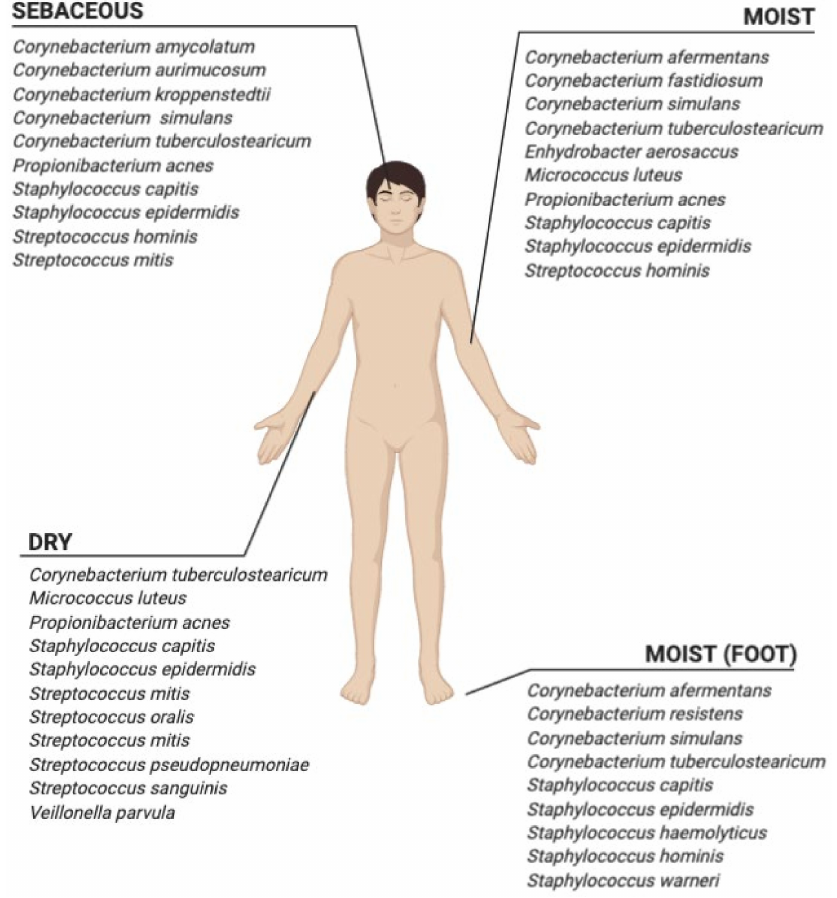
Figure 1. Top 10 abundant bacteria distributed according to physiological grouping of